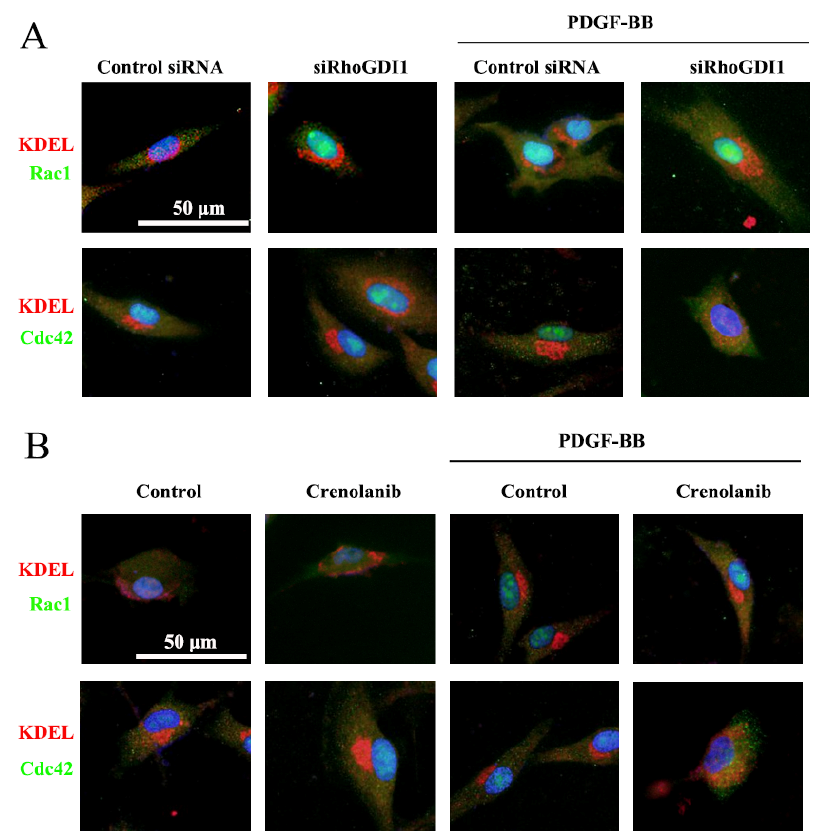
Figure 5. RhoGDI1 suppression ( A ) and crenolanib pretreatment ( B ) promotes the aggregation of Cdc42 in the endoplasmic reticulum (ER) in PDGF-BB-treated HA-VSMCs. Scale bar=50 μ m. ( A , B ) Representative images of Rac1 or Cdc42 (green) and ER (KDEL, red) as double staining (merge). Nuclei were stained with DAPI (blue). ( A ) HA-VSMCs transfected with control siRNA and RhoGDI1 siRNA were treated with 10 ng/mL of PDGF-BB for 24 h. The cells transfected with control siRNA alone were used as control. RhoGDI1 knockdown enhanced the co-localization of the ER and Cdc42 but did not affect the co-localization of the ER and Rac1 in PDGF-BB-treated HA-VSMCs. ( B ) HA-VSMCs were treated with crenolanib (50 nM) for 48 h followed by 10 ng/mL of PDGF-BB for 24 h. Untreated cells were used as control. Crenolanib pretreatment enhanced the co-localization of the ER and Cdc42 but did not affect the co-localization of the ER and Rac1 in PDGF-BB-treated HA-VSMCs.